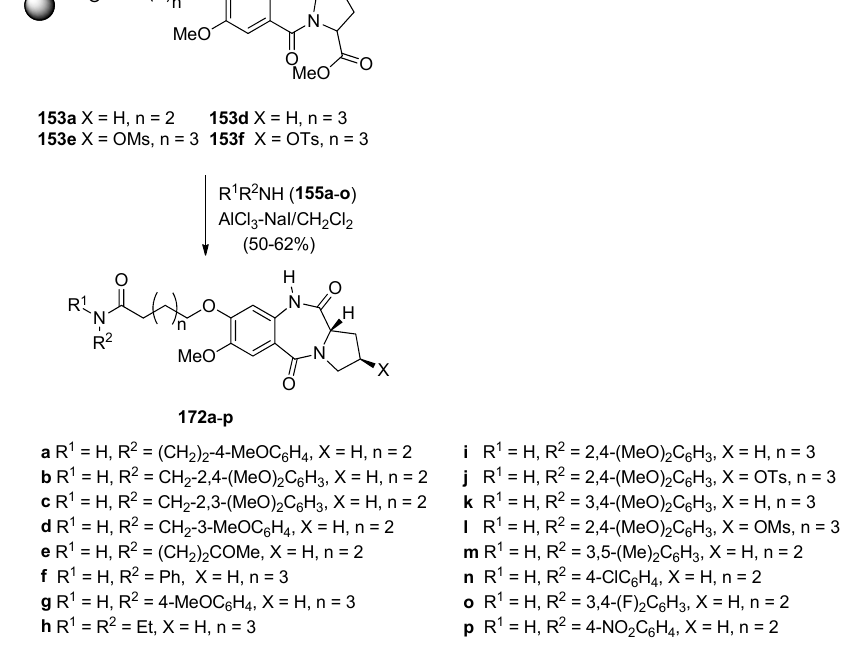
Scheme 29. Synthesis of C8- O -substituted PBD conjugates 172a – p